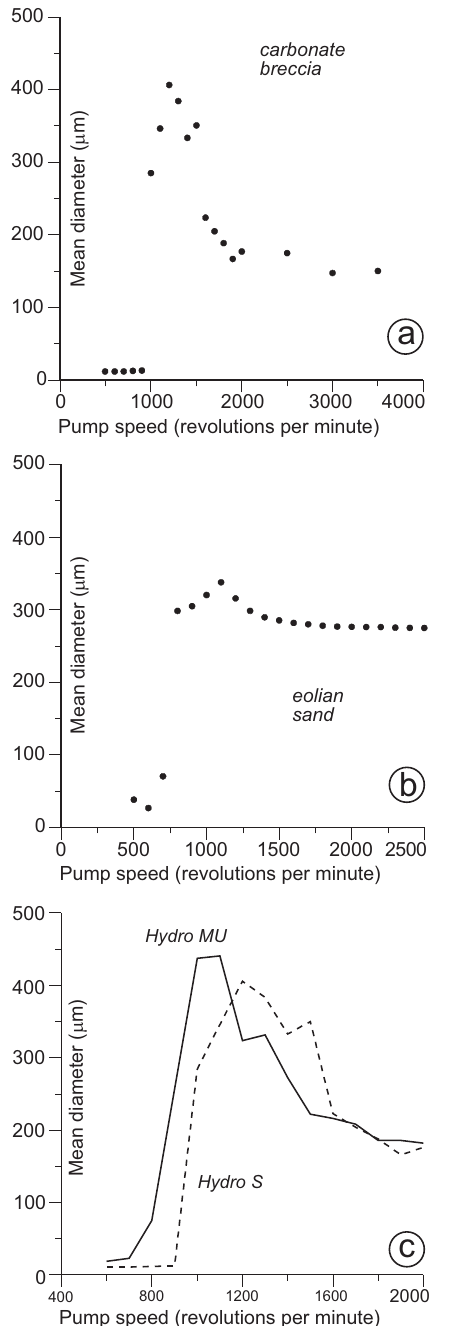
Fig. 6. (a) Pump speed test P 5 performed on sub-sample aliquot CABRE3c by the Hydro 2000 S dispersion unit; mean diame- ter value evolution with increasing the pump speed from 500 up to 3500rpm. (b) Pump speed test P 5 performed on sub-sample aliquot SAND1b by the Hydro 2000 S dispersion unit; mean di- ameter value evolution with increasing the pump speed from 500 up to 2500rpm. (c) Comparison, in the range 500–2000rpm, of the trends of mean diameter values obtained from pump speed tests on sample CABRE. The solid line refers to data in Fig. 3a; the broken line refers to data in Fig. 6a.